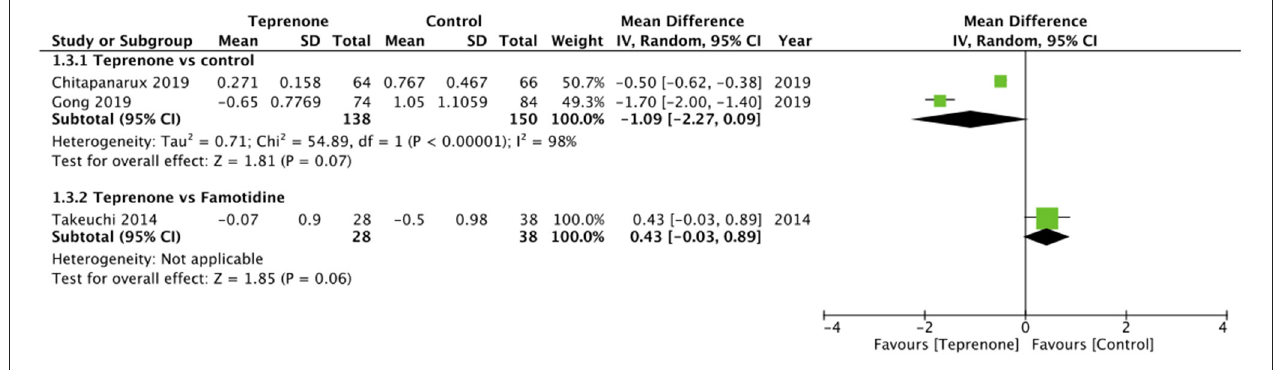
FIGURE 4 | Forest plot for MLS with sub-group analysis based on comparative